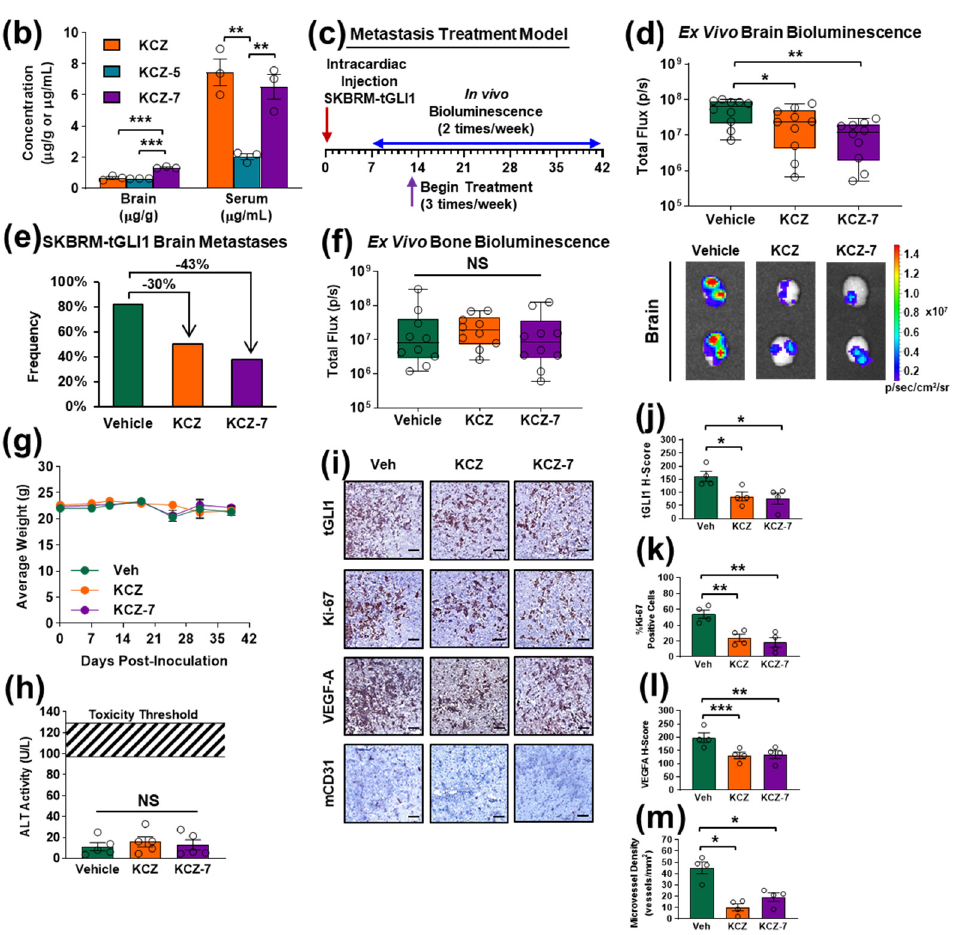
Figure 5. The novel KCZ derivative KCZ-7 retains its tGLI1 selectivity and in vivo efficacy while readily permeating the BBB. ( a ) The structures of KCZ, KCZ-5, and KCZ-7 (top). The effect of treatment with KCZ-5 (left) or KCZ-7 (right) on mammosphere formation of SKBRM cell lines. Asterisks denote comparison to intra-cell line vehicle treatment. ( b ) Concentrations of KCZ, KCZ-5, and KCZ-7 measured in whole mouse brain homogenate or mouse serum. Mice received a single intraperitoneal treatment of 50 mg/kg KCZ, KCZ-5, or KCZ-7. Matched whole blood and brain samples were collected 20 min after treatment and analyzed using mass spectrometry ( N = 3). ( c ) Schema for intracardiac brain metastasis treatment model. ( d ) Ex vivo brain bioluminescence at study endpoint (top) ( N = 10 per group). Representative ex vivo brain bioluminescent images (bottom). ( e ) Brain metastasis incidence rates at study endpoint. ( f ) Ex vivo bone bioluminescence at study endpoint (top) ( N = 10 per group). ( g ) Average weight of mice in each group. ( h ) Serum alanine transaminase (ALT) activity. ( i ) Representative tGLI1, Ki-67, VEGF-A, and mCD31 expression levels as assessed by IHC in mice bearing SKBRM-tGLI1 brain metastases treated with vehicle, 50 mg/kg KCZ, or 50 mg/kg KCZ-7. ( j – m ) IHC quantification of tGLI1 expression ( j ), proliferative index ( k ), VEGF-A expression ( l ), and microvessel density ( m ) levels of SKBRM-tGLI1 brain metastases ( N = 4 per group). Scale bar represents 100 µ m. NS, not significant; *, p < 0.05; **, p < 0.01; ***, p < 0.001; ****, p < 0.0001; two-way ANOVAs with post hoc Dunnett’s multiple comparison test ( a ) or one-way ANOVA with post hoc Tukey’s multiple comparison test ( b , d , f , h , i – m ) were used to calculate p